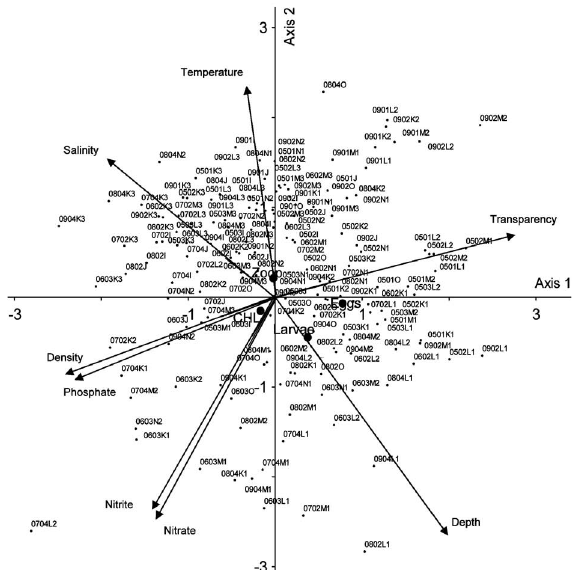
Fig . 7. – CCA ordination diagram using the same matrix with sites and environmental variables during winter and early spring 2005- 2009 in Bahía Magdalena, Baja California Sur. Arrows represent significant explanatory factors; arrowheads indicate the positive direction for the different variables. Station points (year, month,